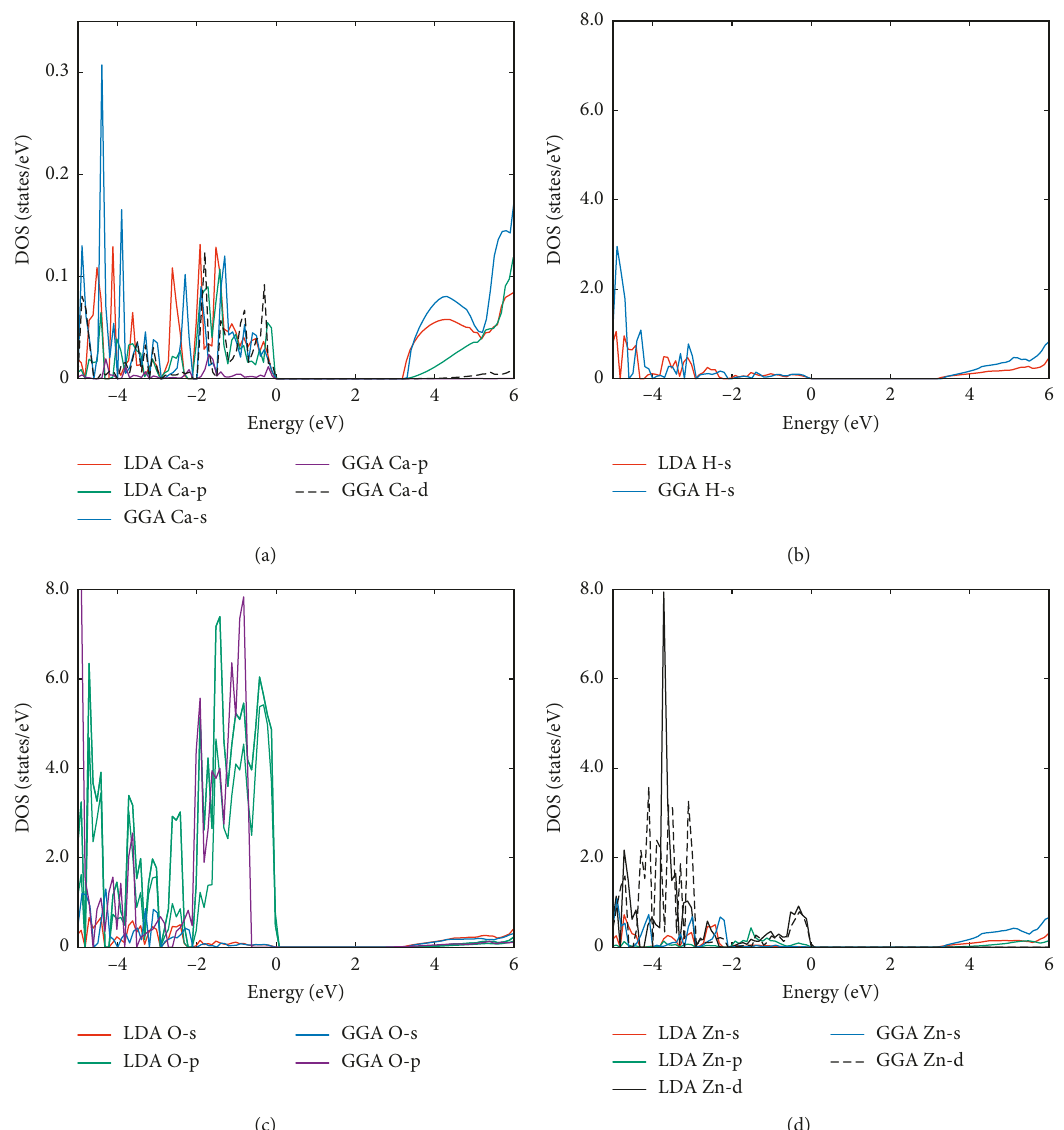
Figure 3: Partial density of states determined for qatranaite. The zero of the energy scale is shifted to the top of the valence